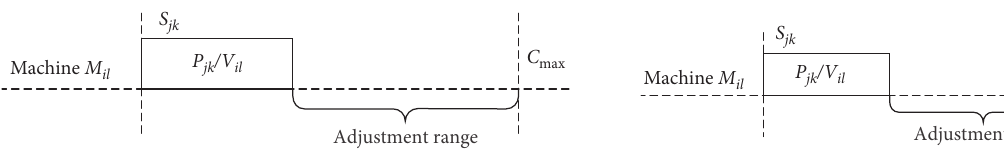
jk is not the last operation